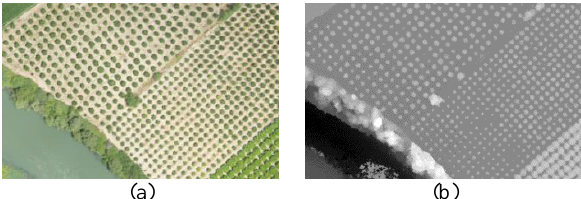
Figure 1. Test patch #1. (a) RGB UAV image acquired on July 2016, and (b) the photogrammetric DSM generated using dense image matching (bright tones represent elevated